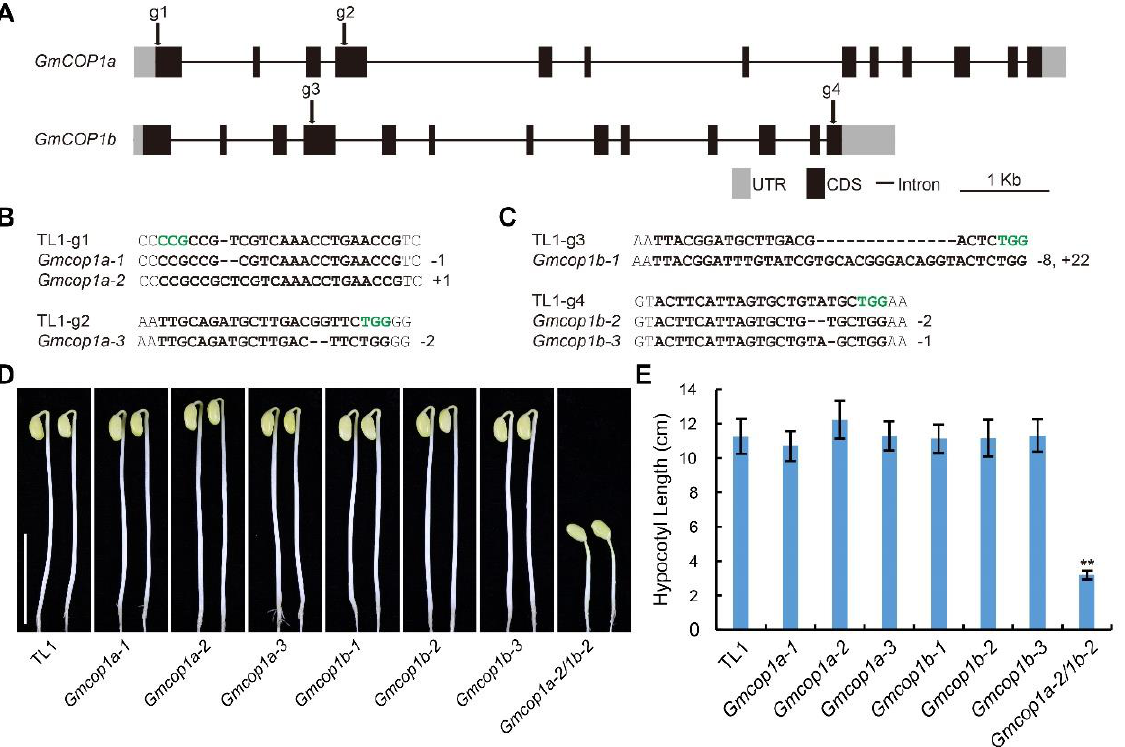
Figure 3. Generation and characterization of the CRISPR-Cas9 engineered Gmcop1a , Gmcop1b, and Gmcop1a1b mutants. ( A ) Schematic diagram showing the genomic structures of indicated genes and the gRNA targeting sites (g1 to g4). Dark boxes represent coding sequence (CDS). Grey boxes denote untranslated region (UTR). Dark lines indicate intergenic region (Intron). scale bar = 1 Kb. ( B , C ) Alignment of the DNA sequences around the gRNA targeting sites in the wild type TL1, Gmcop1a mutants ( B ) and Gmcop1b mutants ( C ) . The gRNA targets and PAM sequences are highlighted in bold and green font, respectively. ( D ) Representative images of the indicated lines grown in darkness for 5 days. Scale bar = 10 cm. ( E ) Statistical analysis of hypocotyl length of different lines in ( D ). The values represent the means ± SD ( n ≥ 9). Asterisks indicate significant difference compared to TL1 by Student’s t -test (** p < 0.01).